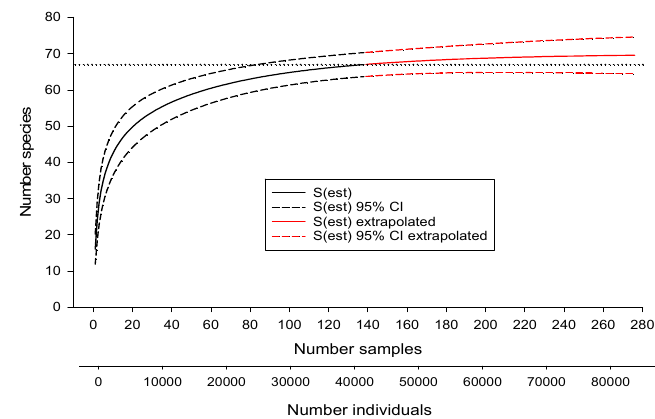
Figure 2. Relationship between estimated number of fish species [S(est)], confidence intervals (CI), and number of samples and individuals collected from the Savannah River Site plus the extrapolated number if additional samples had been collected. Horizontal dotted line represents actual number of species collected by extensive sampling. Table 2. Number of fish species in Savannah River Site streams estimated by species richness estimators based on data from all sample sites or subsets of sample sites. Also shown are the minimum number of samples needed to estimate 67 species, the number actually